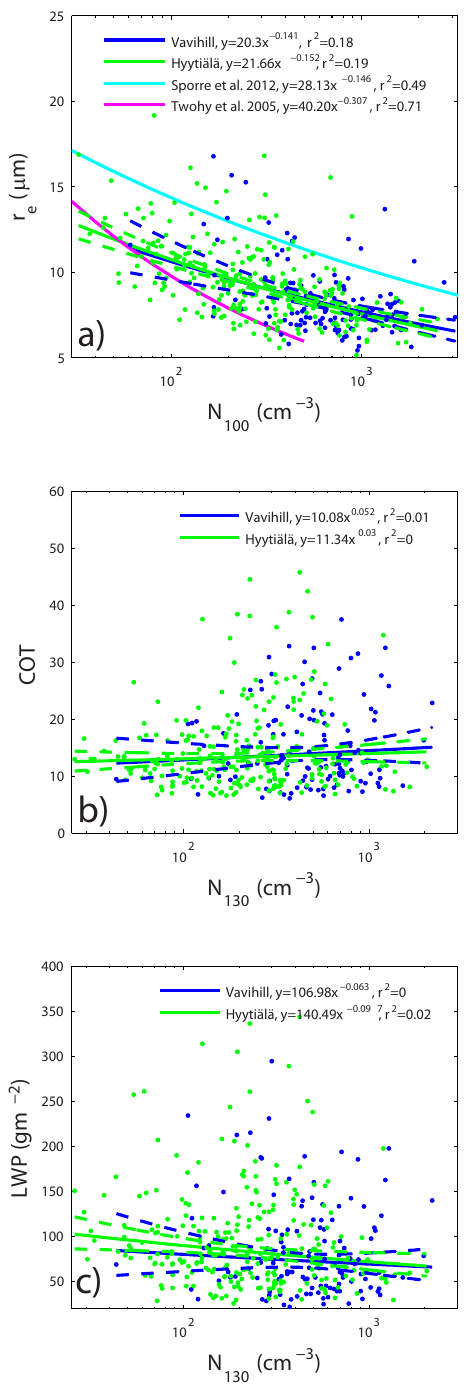
Figure 3. Relationship between (a) r e and N 100 , (b) COT and N 130 and (c) LWP and N 130 for Vavihill (blue lines and dots) and Hyytiälä (green lines and dots). Included in Fig. 3a are also rela- tionships obtained by Sporre et al. (2012) and Twohy et al.